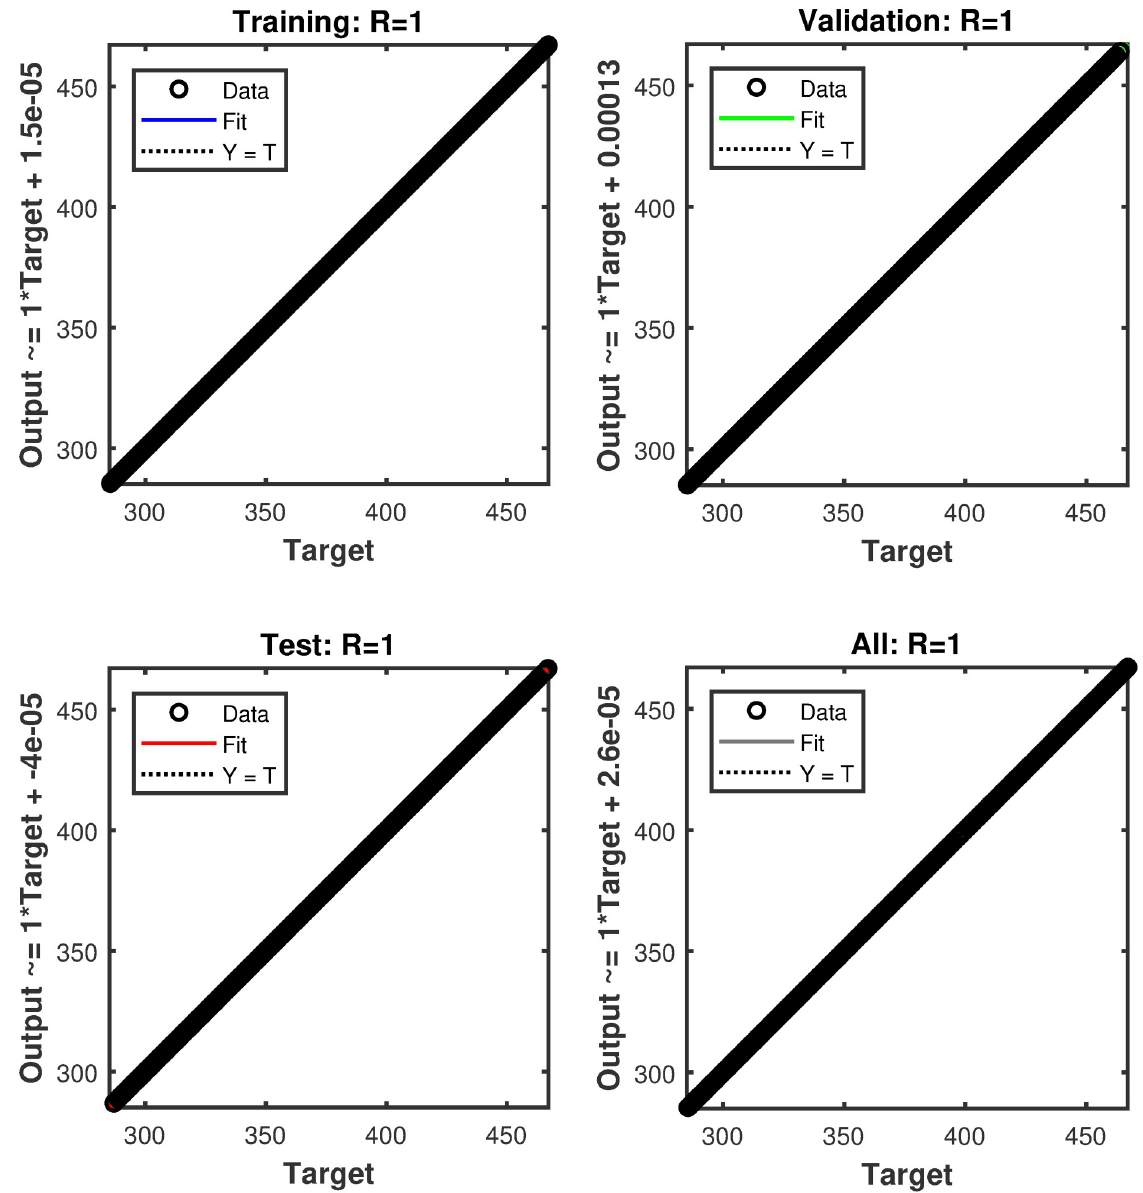
Fig 10. The regression plots during the estimation of V ref